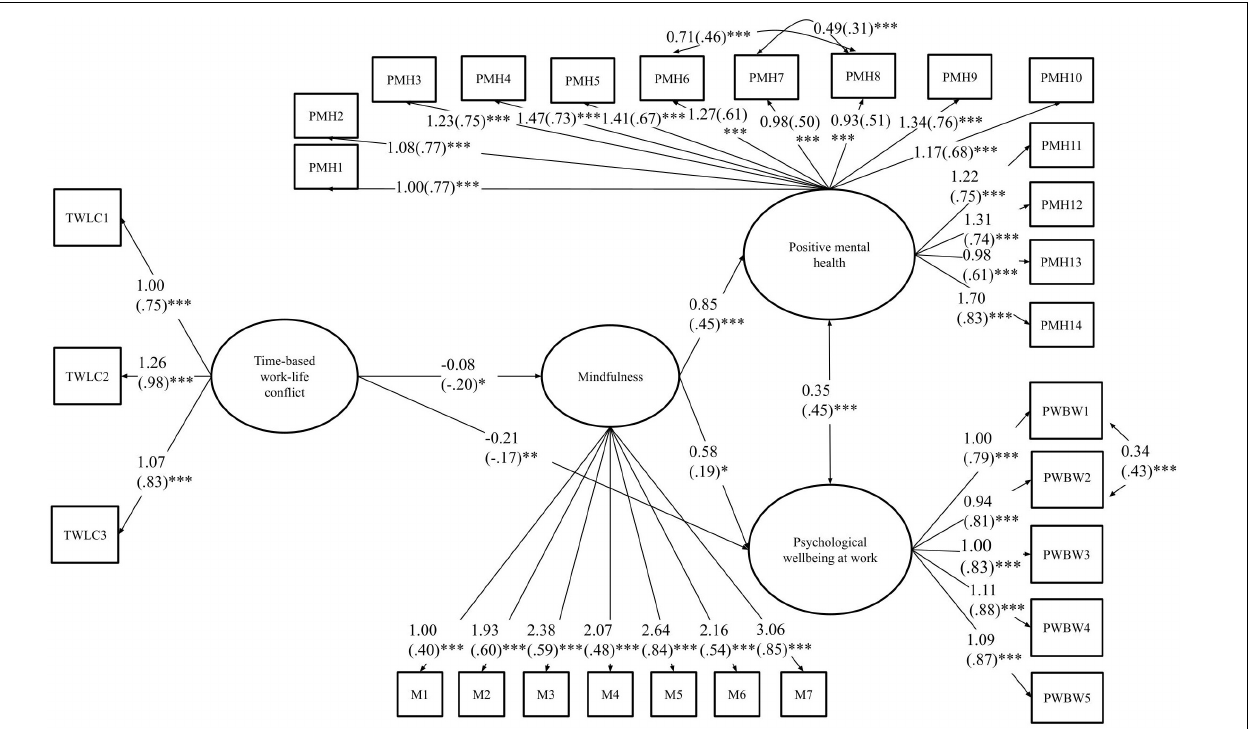
FIGURE 1 | The (in)direct effect of time-based WLC on positive mental health and psychological wellbeing at work. The figure includes the unstandardized estimates accompanied by standardized estimates in brackets. Only significant links between core study variables are shown in the figure. Control variables described in the methods section were also included, but not represented to facilitate ease of reading. ∗ p < 0.05, ∗∗ p < 0.01, ∗∗∗ p <